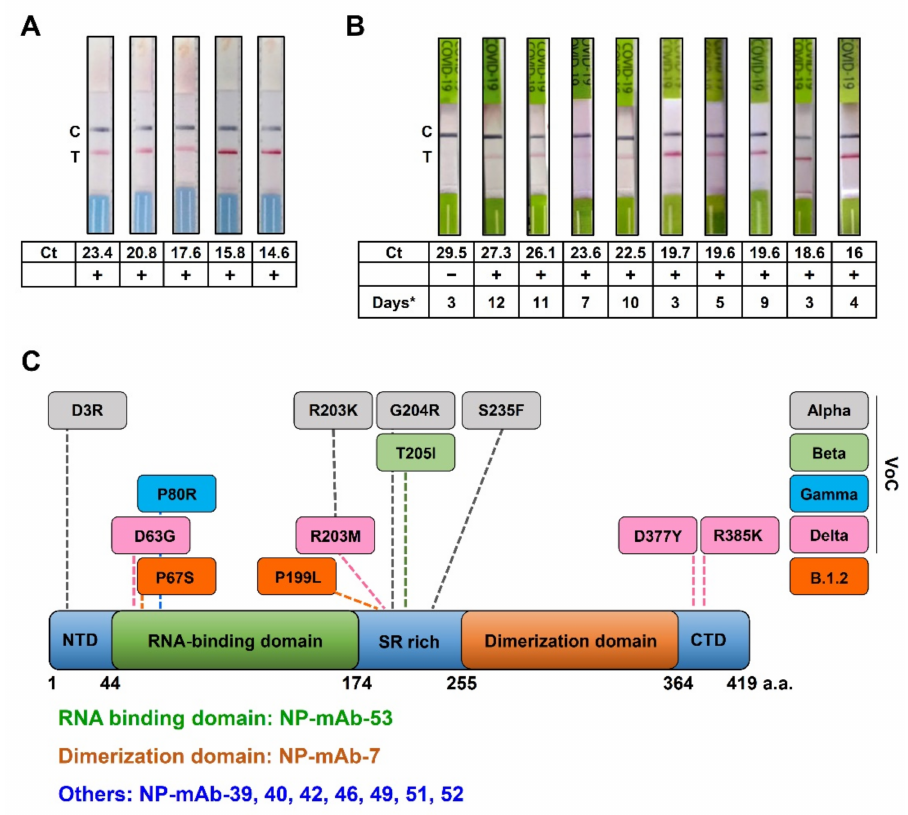
Figure 4. Clinical verification of the antigen rapid tests. ( A ) NP mAb-40/7 LFIA strips were used to probe five frozen samples with Ct values between 14.6 and 23.4 for the viral E gene. ( B ) NP mAb-40/7 LFIA strips were used to probe ten freshly collected positive patient samples with Ct values between 16 and 29.5 for the viral E gene. Days* means the days after onset to sampling. ( C ) Recognition sites of anti-NP mAbs on SARS-CoV-2 NP. SARS-CoV-2 NP contains 419 amino acid residues (a.a.). Each domain length is shown underneath the illustration. Amino acid mutations in SARS-CoV-2 NP are labeled for the different variants of concern (VoCs). The binding domains of the anti-NP mAb we studied are listed in the low